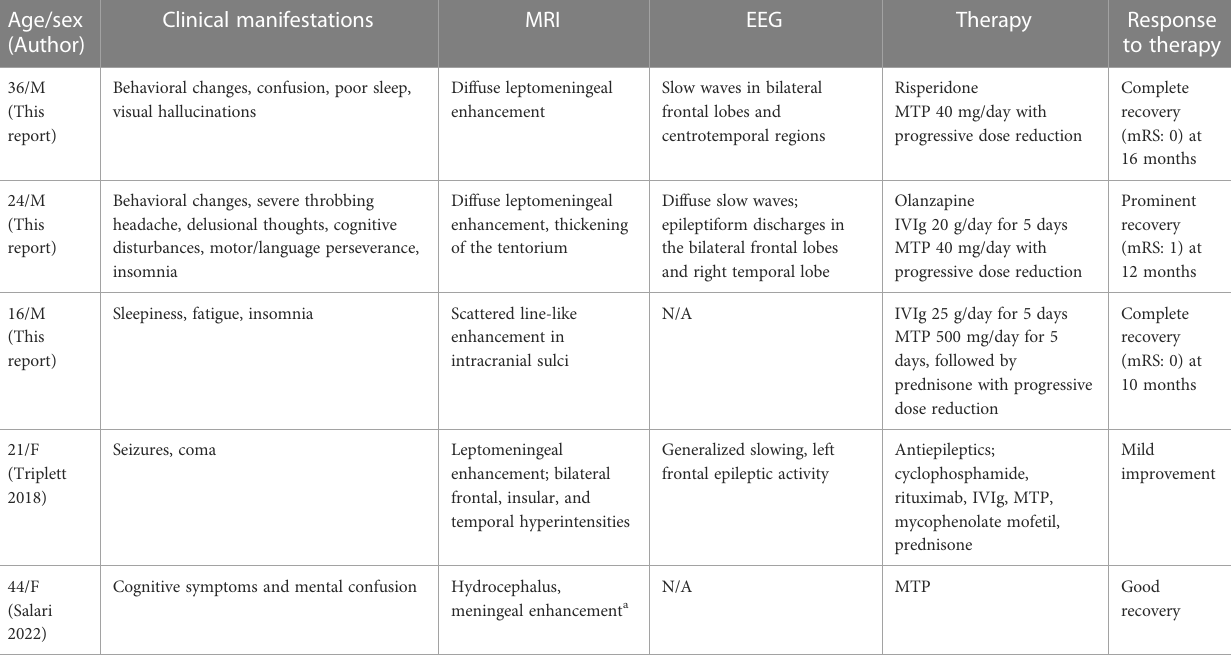
TABLE 1 Summary of clinical and demographic features of GAD65 patients with meningeal